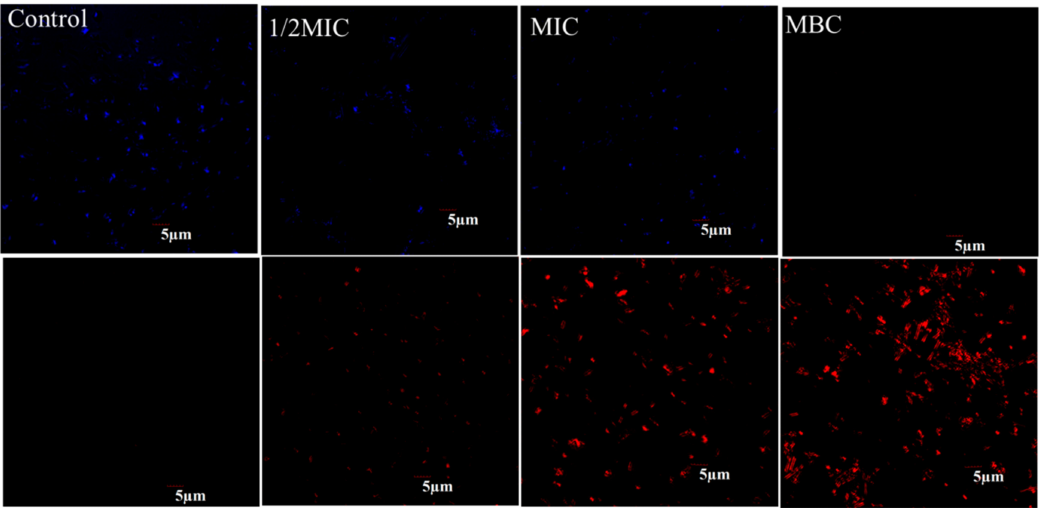
Figure 2. CLSM was used to analyze the viability of P. syringae exposed to different concentrations of juglone.